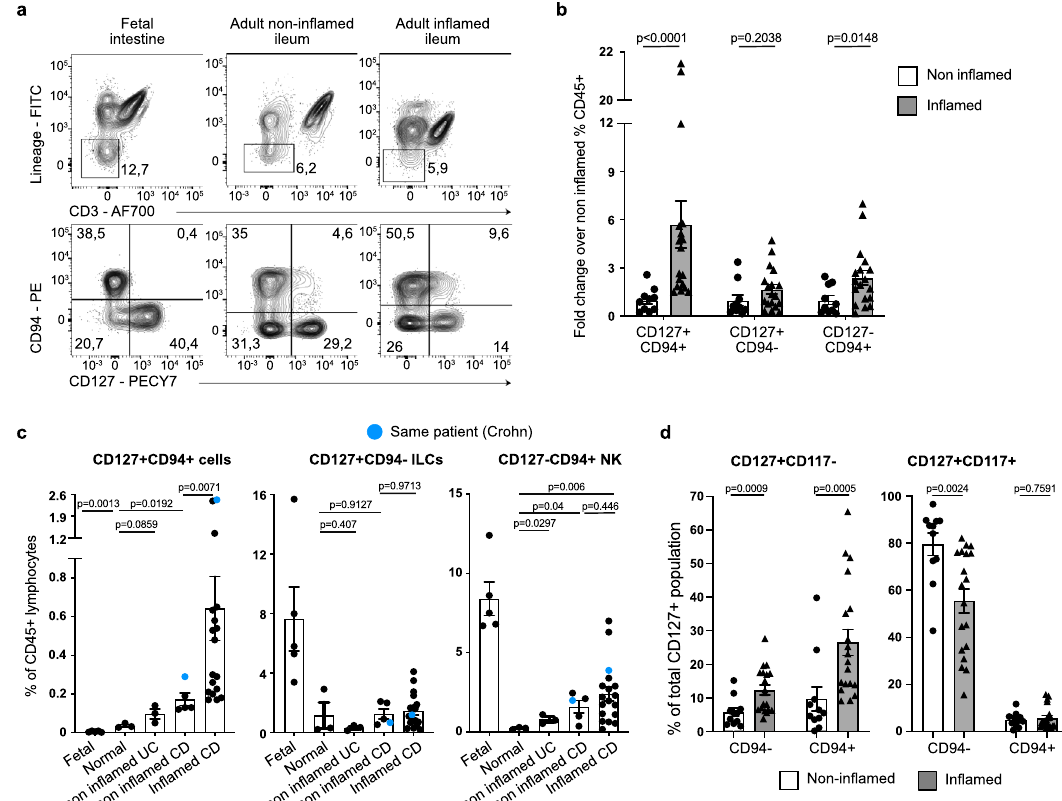
Fig. 4 Granulysin-expressing CD117 − population B is expanded in in fl amed intestine from Crohn ’ s disease patients. a Expression pattern of CD94 and CD127 in live CD45 + lineage-CD3 − cells (similar as in Fig. 1a) in fetal intestine, adult macroscopically non-in fl amed en in fl amed intestine. b The fold increase of indicated subsets in in fl amed Crohn ’ s Disease (CD) specimen ( N = 18) over the average of the frequency of non-in fl amed specimen ( N = 11, containing normal ( N = 3), macroscopically non-in fl amed Ulcerative Colitis (UC) ( N = 3) and non-in fl amed CD intestine ( N = 5)). Bar graphs show the fold increase ±SEM. Each dot represents one donor. c Bar graphs depict indicated populations as a percentage ±SEM of live CD45 + lymphocytes in fetal intestine ( N = 5), normal intestine ( N = 3), macroscopically non-in fl amed ulcerative colitis (CU) intestine ( N = 3), non-in fl amed Crohn ’ s Disease (CD) intestine ( N = 5) and in fl amed CD intestine ( N = 18). Each dot represents one donor, and the blue dots indicate resection samples from the same patients. d Bar graphs depict the mean frequency ±SEM of indicated populations as a percentage of the total CD127 + population. The in fl amed CD specimen are N = 18 and the non-in fl amed specimen are N = 11 (containing normal ( N = 3), macroscopically non-in fl amed Ulcerative Colitis (UC) ( N = 3) and non- in fl amed CD intestine ( N = 5). Each dot represents one donor. All data were tested for normal distribution using the Shapiro – Wilk test. All normally distributed data were tested with an unpaired t-test and not normally distributed data were tested with a Mann-Whitney test. All p values are